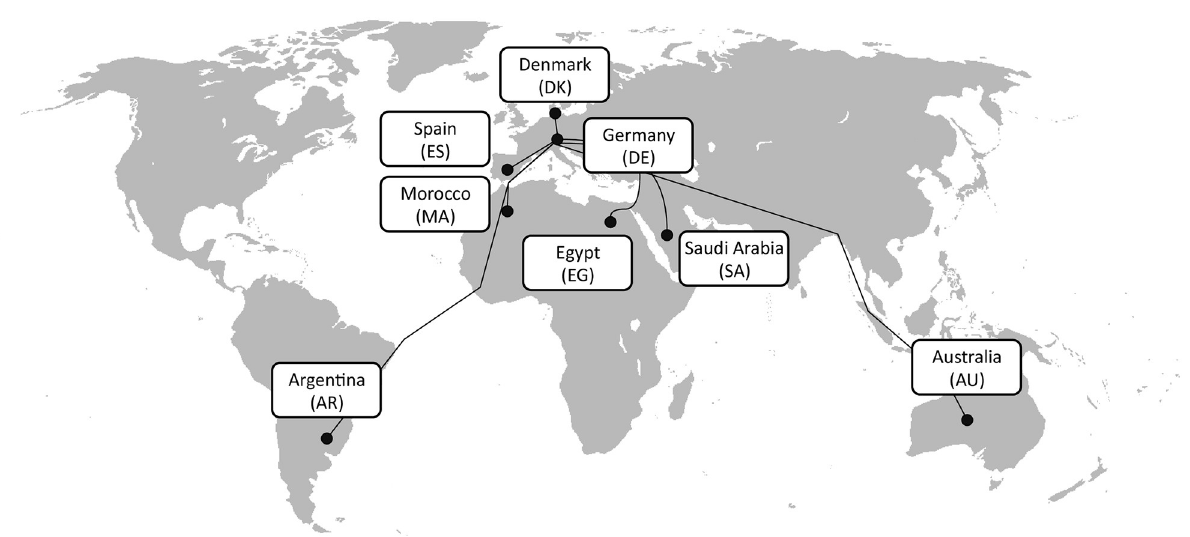
PLOS ONE | https://doi.org/10.1371/journal.pone.0281380 February 9,